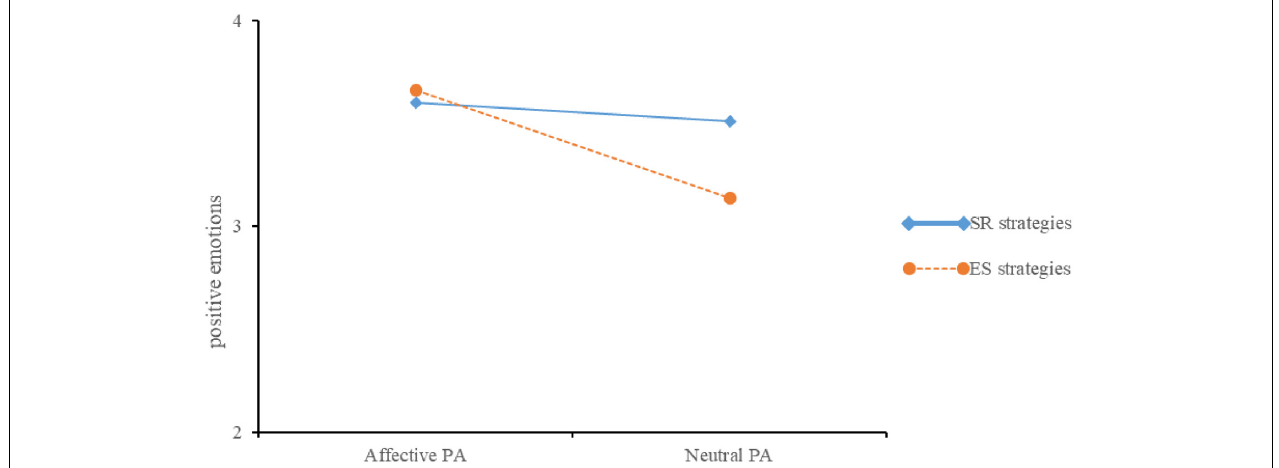
FIGURE 3 | The positive emotions on the second measurement point for the four groups in Experiment